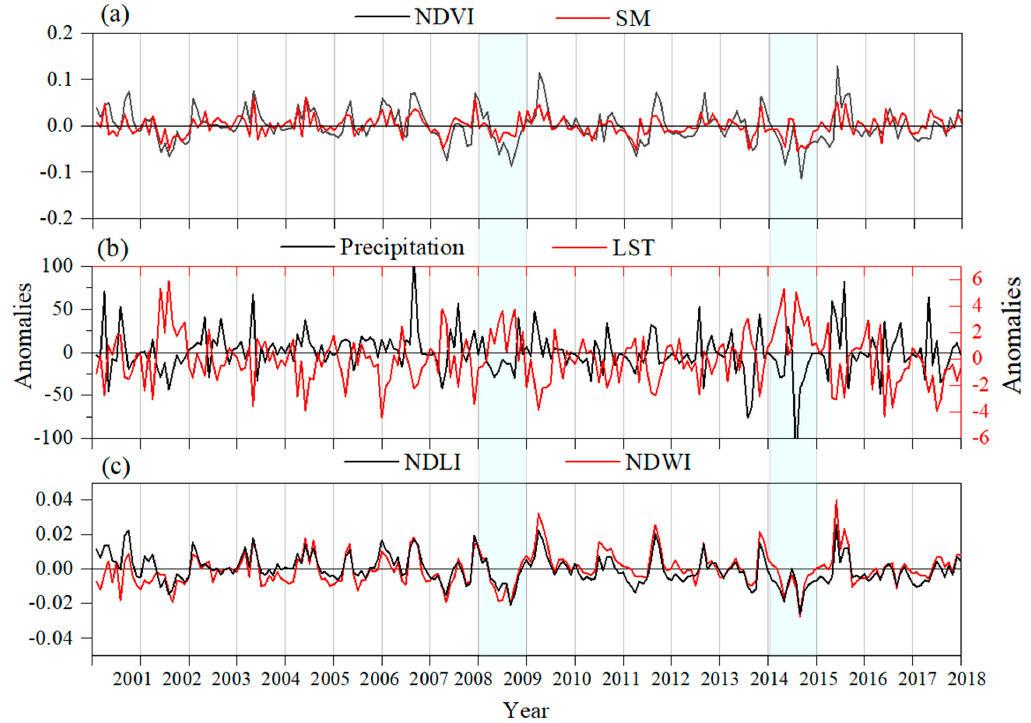
Figure 8. The monthly mean anomaly time series values of ( a ) NDVI and soil moisture, ( b ) precipitation and LST, and ( c ) NDLI and NDWI for 38E–39E, 9N–10N. NDVI anomalies in this region were near normal for several years. In contrast, it showed slight green up in 2010 and late 2016, as conditions translate to weak La Niña. Maximum NDVI departures were observed in 2009 and 2015, where NDVI gradually decreased and remained slightly below average. In particular, the 2015 events were accompanied by higher precipitation anomalies of about − 100 mm. There is an exact resemblance between the other parameters, with a clear identification of the drought and normal years. Considering the spatial drought patterns derived from VCI (Figure 5), the intense drought years certainly resulted in a decline in soil moisture and water availability. The water stress situations in the root zone were well captured by soil moisture values. The NDWI and NDLI indicate a similar pattern to that of NDVI, where they reached peaks in 2010 and 2016. The Pearson correlation coefficients between NDVI and other factors (precipitation, soil moisture, LST, NDWI, NDLI, MEI, and DMI) on a seasonal time scale for the whole study record were computed to assess the relationship between them. The Pearson correlation coefficient was